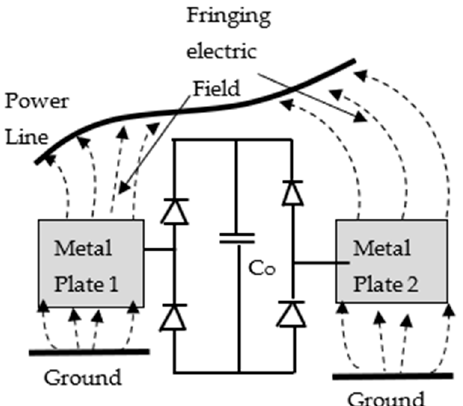
Figure 2. Schematic showing the fringing electric fields. Induced charges from the live wire creates fringing electric fields between the plates and the live wire, and also between the plates and the earth.